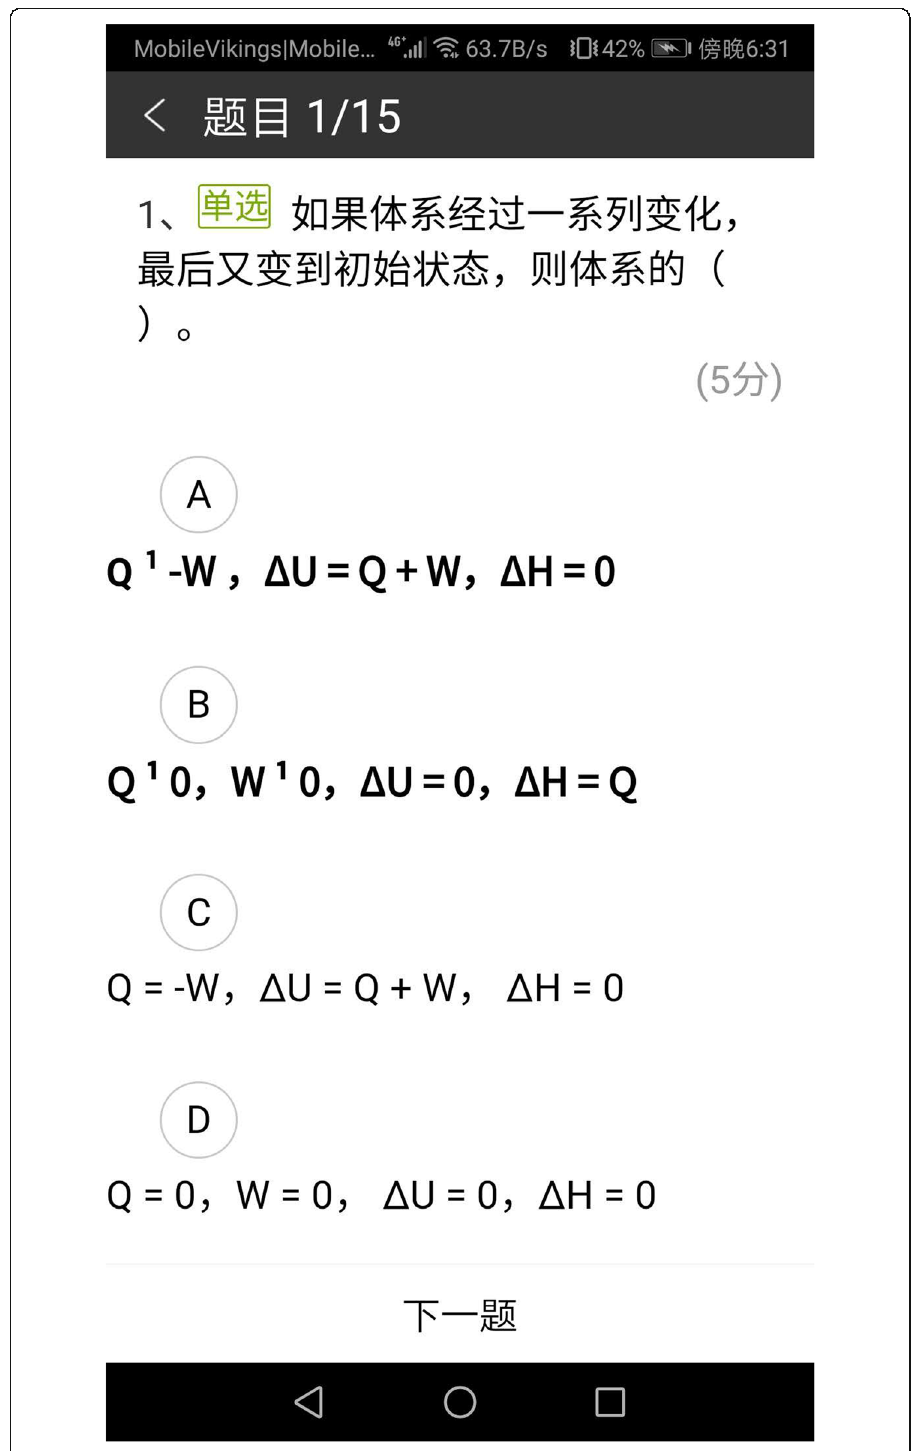
Fig. 2 An example of an online exercise from a selected course. Each unit of the course platform has a matching exercise test, submission deadline and corresponding scores. Students can use those online exercises to test the effect of watching the